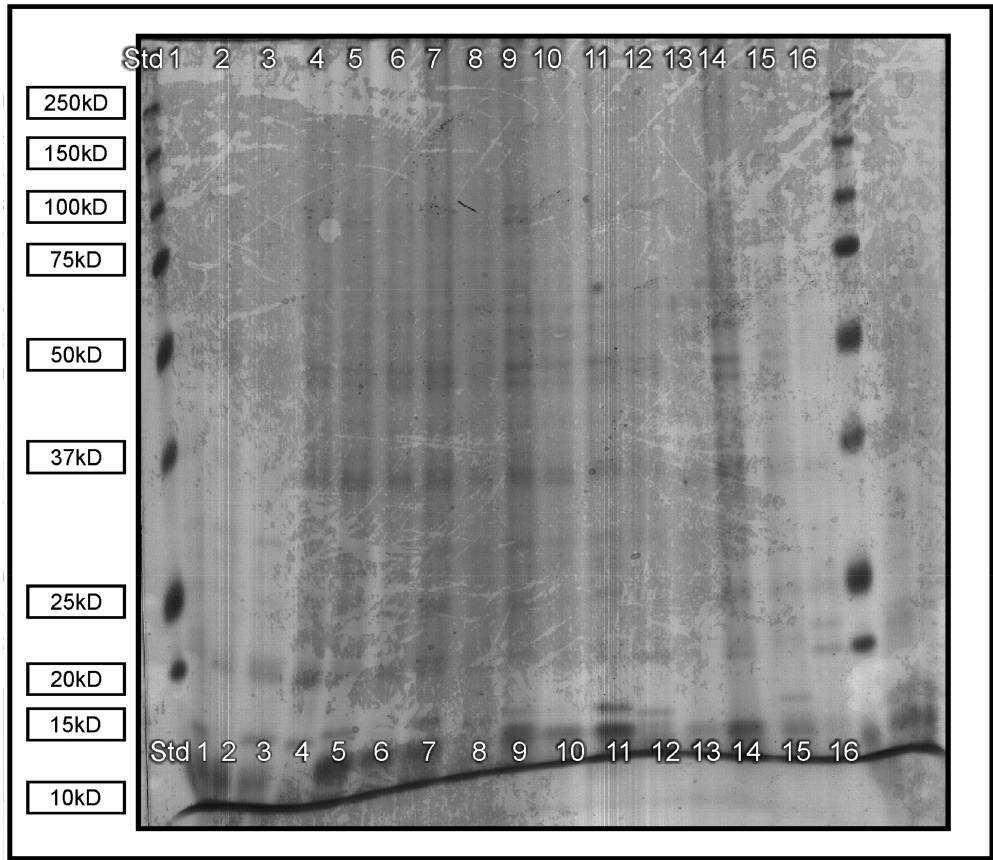
Figure 1. SDS-PAGE electrophoretogram image (February: 1 = Algerian, 2 = Morado, 3 = Gymno-Carpo, 4 = Robusta. May: 5 = Algerian, 6 = Morado, 7 = Gymno-Carpo, 8 = Robusta. June: 9 = Algerian, 10 = Morado, 11 = Gymno-Carpo, 12 = Robusta. August: 13 = Algerian, 14 = Morado, 15 = Gymno-Carpo, 16 =